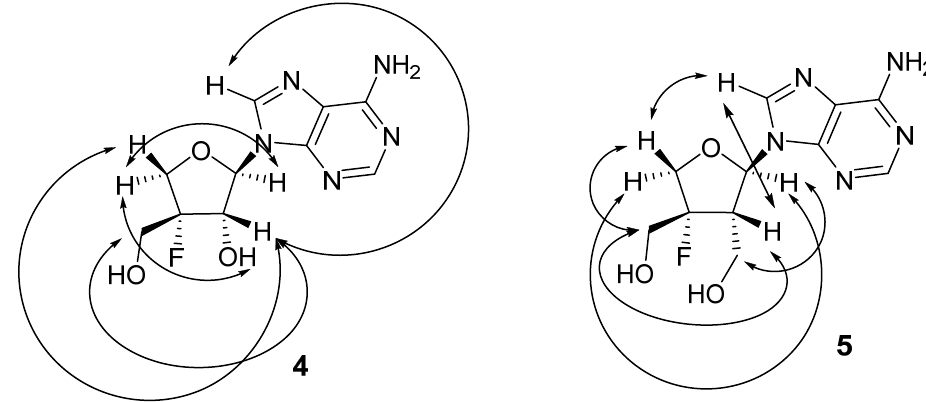
Figure 2. The observed proton NOE interactions (shown with arrows) important for the β-configu- ration determination of nucleosides 4 and 5 .